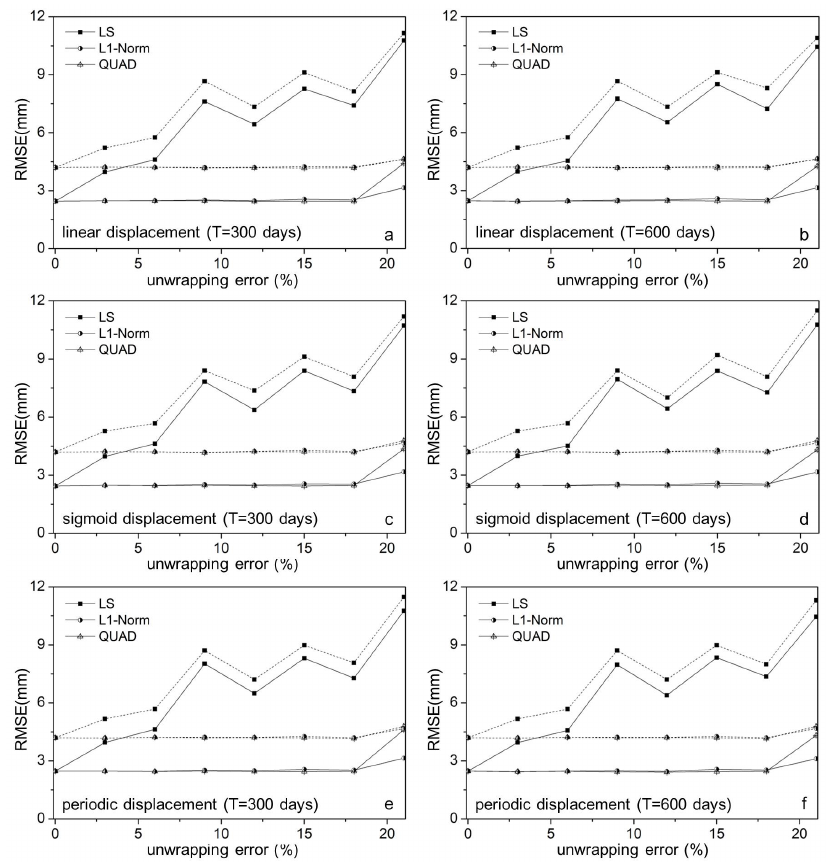
Figure 3. Monte Carlo simulation results. The solid line corresponds to 2mm atmospheric noise level, while the dashed line corresponds to the 4mm atmospheric noise level.